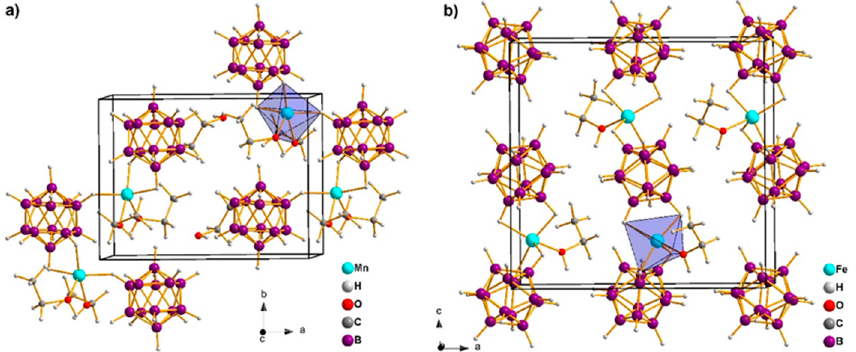
Figure 9. ( a ) View of the Mn coordination square pyramid bridging two closo-borate anions in m -Mn(EtOH) 2 (B 12 H 12 ) • EtOH, and forming zig-zag chains along the b -axis. Only upper half of the unit cell (0.5 < z < 1) is shown for clarity. The closo -borate anions are packed in pseudo-hexagonal layers perpendicular to c -axis forming deformed rhombic-prisms (B 12 H 12 ) 8 containing ethanol molecules. ( b ) View of the Fe coordination triangular bipyramid bridging two closo-borate anions in o -Fe(EtOH)(B 12 H 12 ), and forming chains along the c -axis. The closo -borate anions are packed in nearly regular square layers perpendicular to b -axis forming cubes (B 12 H 12 ) 8 containing ethanol molecules. Both structures optimized by DFT.